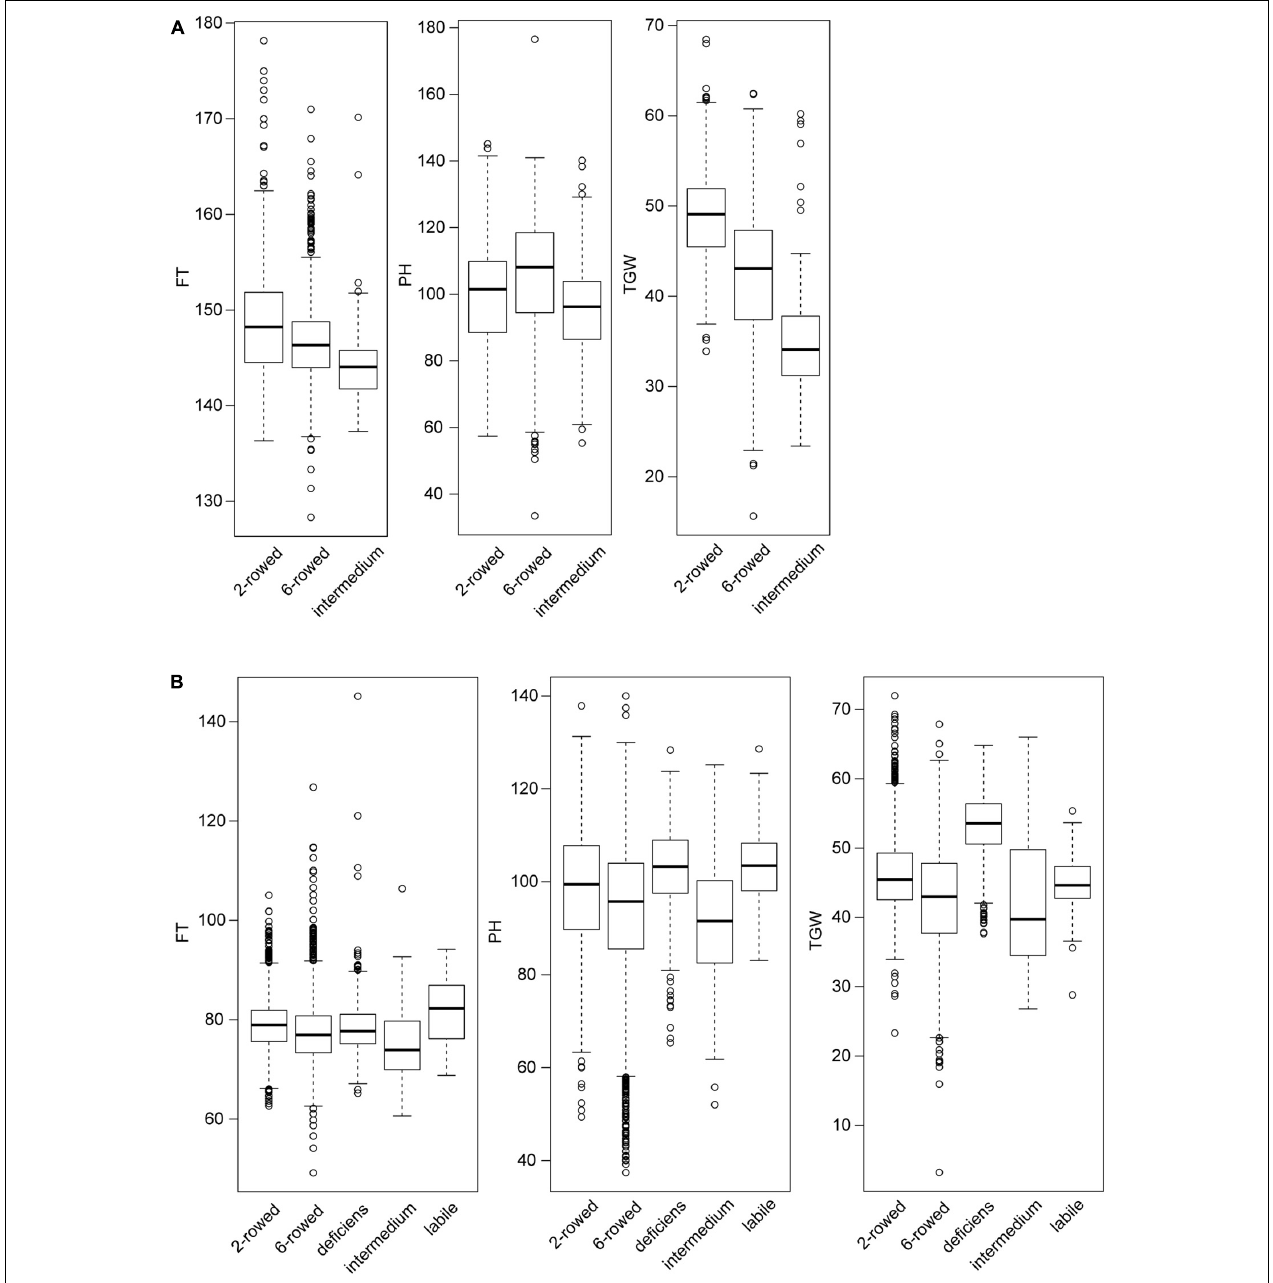
FIGURE 2 | The distribution of phenotypic values for flowering time (FT), plant height (PH), and thousand grain weight for each row type subpopulation of (A) winter and (B) spring barley accessions. For the box-whisker plots, we used the standard settings of the R function “boxplot.” The horizontal line in the middle of the boxes indicates the median of the data. The boxes extend to the first and third quantile. And the vertical lines extend further to 1.5 inter-quantile range, which is the distance between the first and the third quantiles. All other observed points are plotted as outliers.